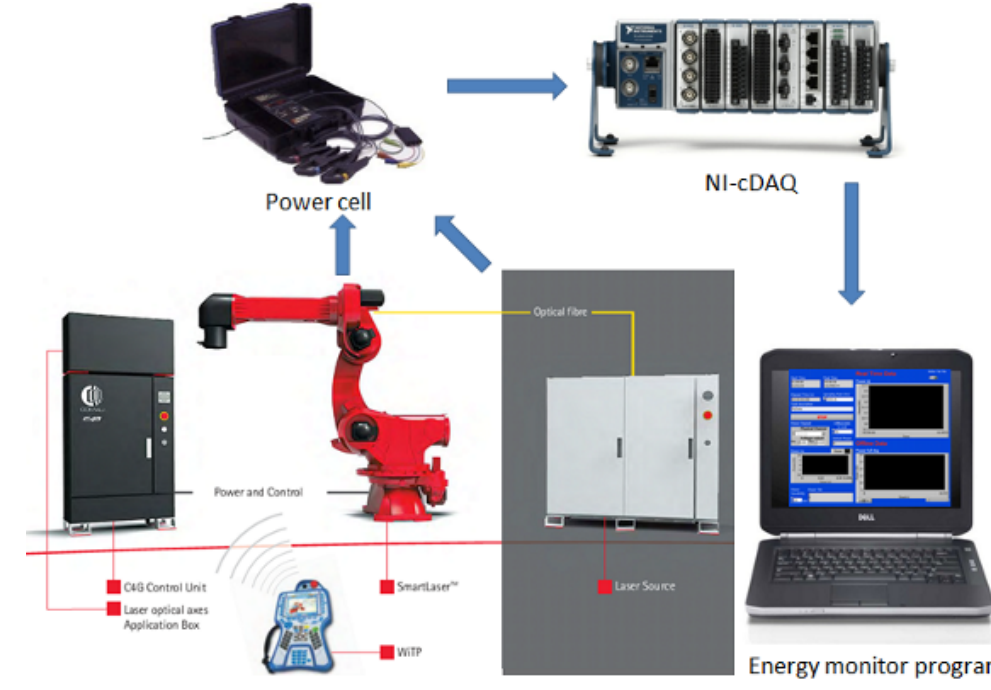
Figure 7. Setup of measurement